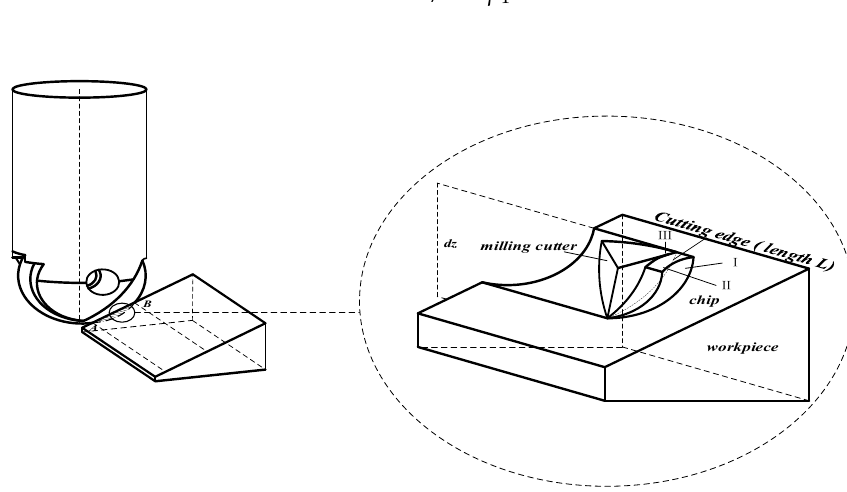
Figure 1. Simplification of a heat source model for ball-end milling cutters.